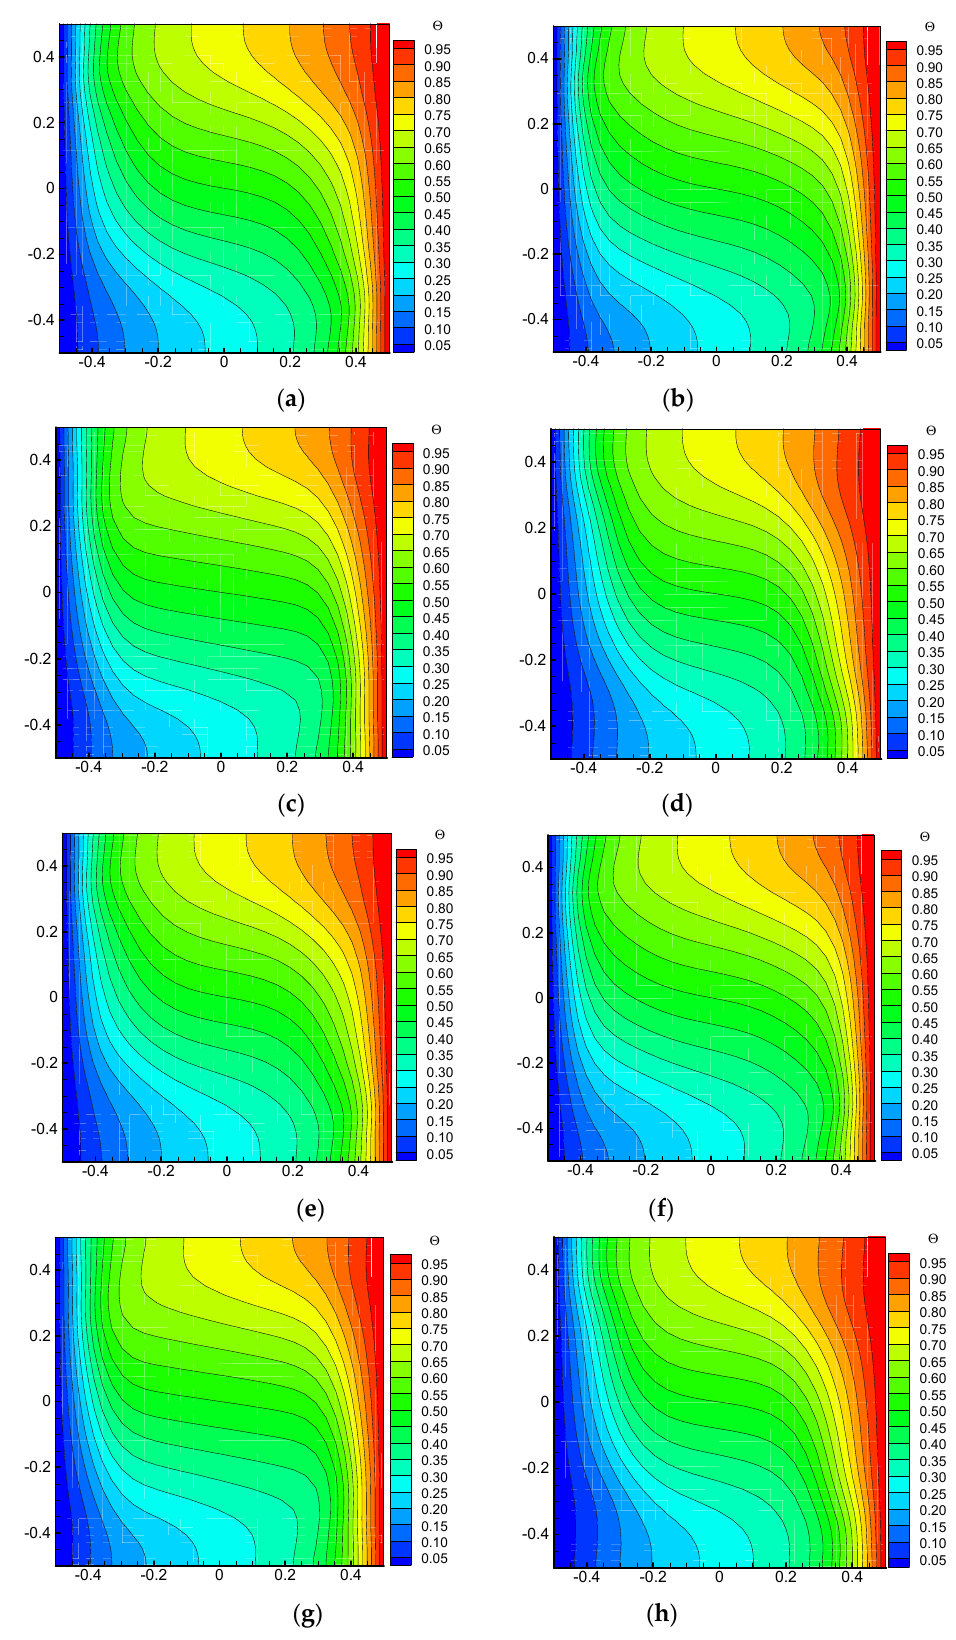
Figure 8. Temperature field evolution at y-o-z plane for Case 1: ( a ) ϕ = 0 (+) ; ( b ) ϕ = ϕ ( c ) ϕ = ϕ m ; ( d ) ϕ = ϕ m /2 ( − ) ; ( e ) ϕ = 0 ( − ) ; ( f ) ϕ = − ϕ m /2 ( − ) ; ( g ) ϕ = − ϕ m ; ( h ) ϕ = − ϕ m /2 (+)